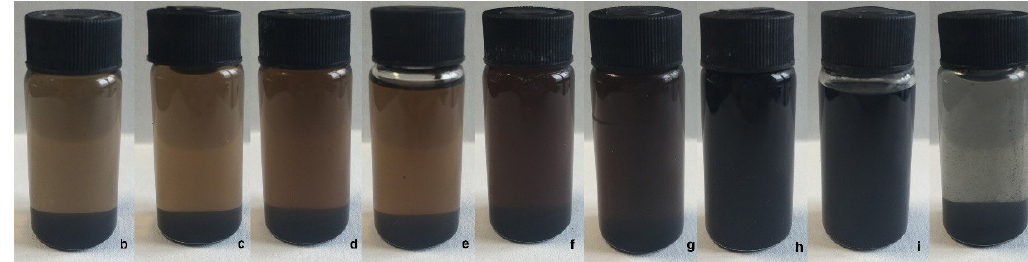
Figure 7. Digital pictures of ORGO and HRGO. (( b ) ORGO at 35 °C, 0.5 h; ( c ) ORGO at 35 °C, 5 h; ( d ) ORGO at 50 °C, 0.5 h; ( e ) ORGO at 50 °C, 5 h; ( f ) ORGO at 80 °C, 0.5 h; ( g ) ORGO at 80 °C, 5 h; ( h ) ORGO at 120 °C, 0.5 h; ( i ) ORGO at 120 °C, 5 h; ( j ) HRGO, (80 °C, 5 h)).